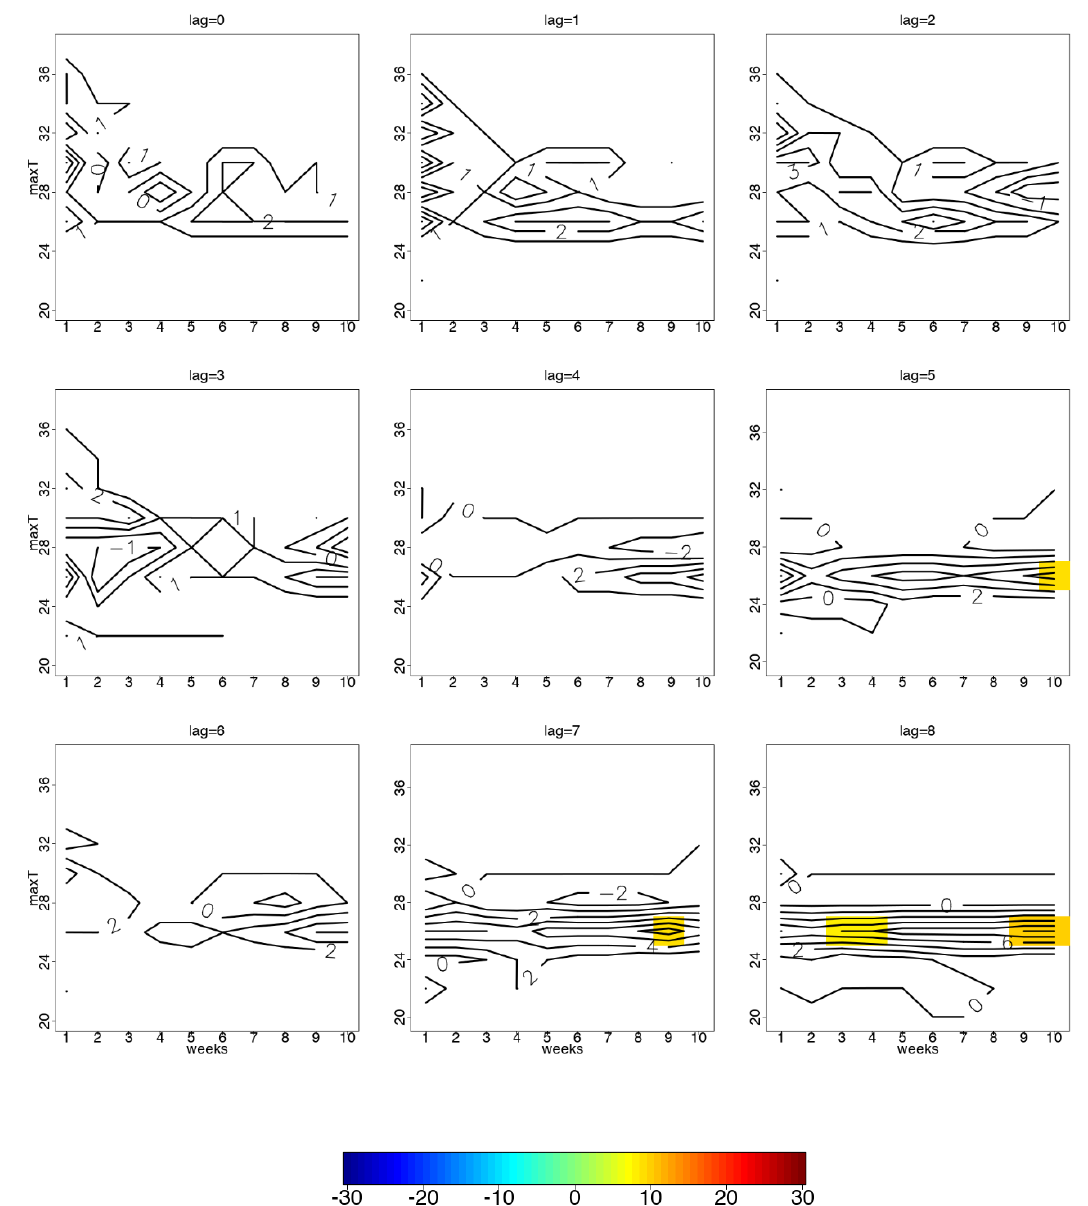
Figure 10. Statistically significant contour differences in anomalously high and low diarrhoea case counts for lag 0 to 8 weeks per consecutive weeks of maximum temperature among individuals under 5 years of age for season SON. X-axis represents number of consecutive weeks in which the average temperature reached over Y-axis representing temperature in degrees Celsius (°C). Warm colours represent higher frequency of (X, Y) occurring when diarrhoea case counts were anomalously higher than average.